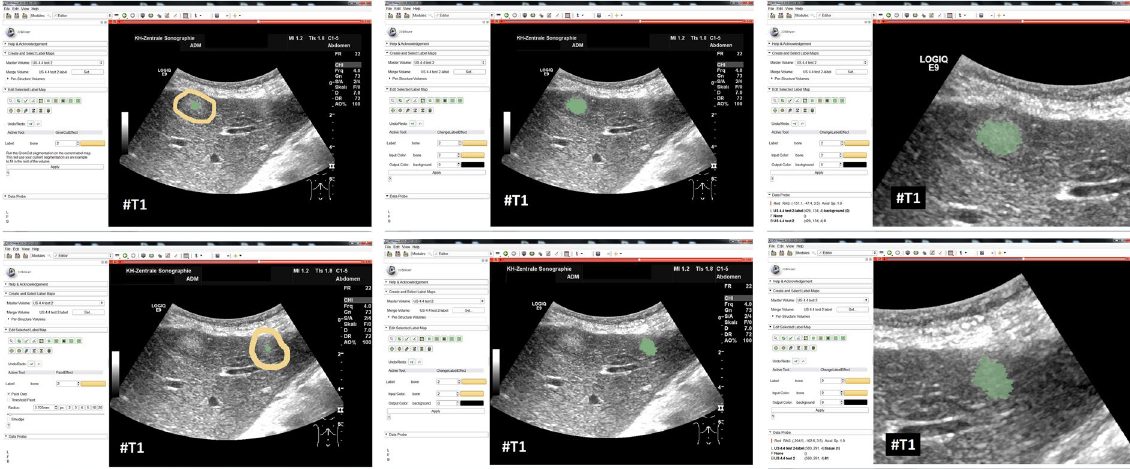
Figure 14. GrowCut segmentation results for the two metastases from Fig. 9. The left images show the manual initialization of GrowCut: the metastases were initialized with green, and the backgrounds were initialized with yellow. The images in the middle show the segmentation results of GrowCut (green). The right images show a closer view of the segmentation results (green) with a lower opacity.